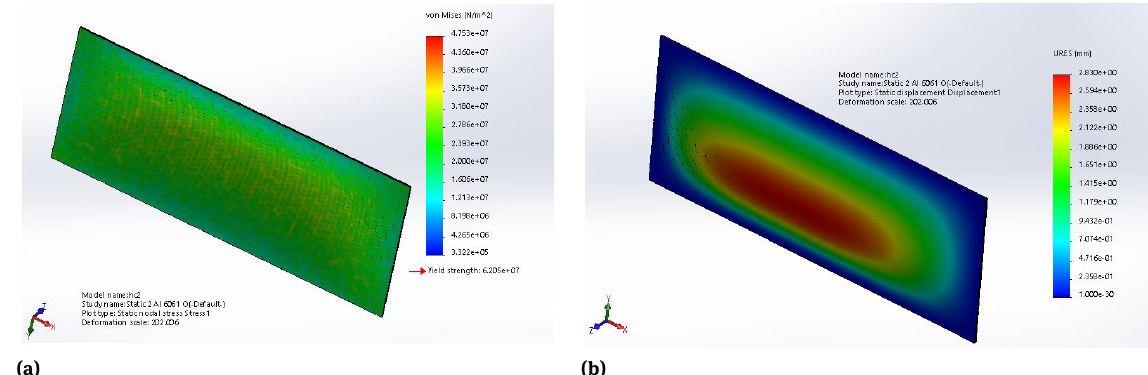
Figure 10: Results for the general honeycomb: (a) Von Mises stress and (b) resultant